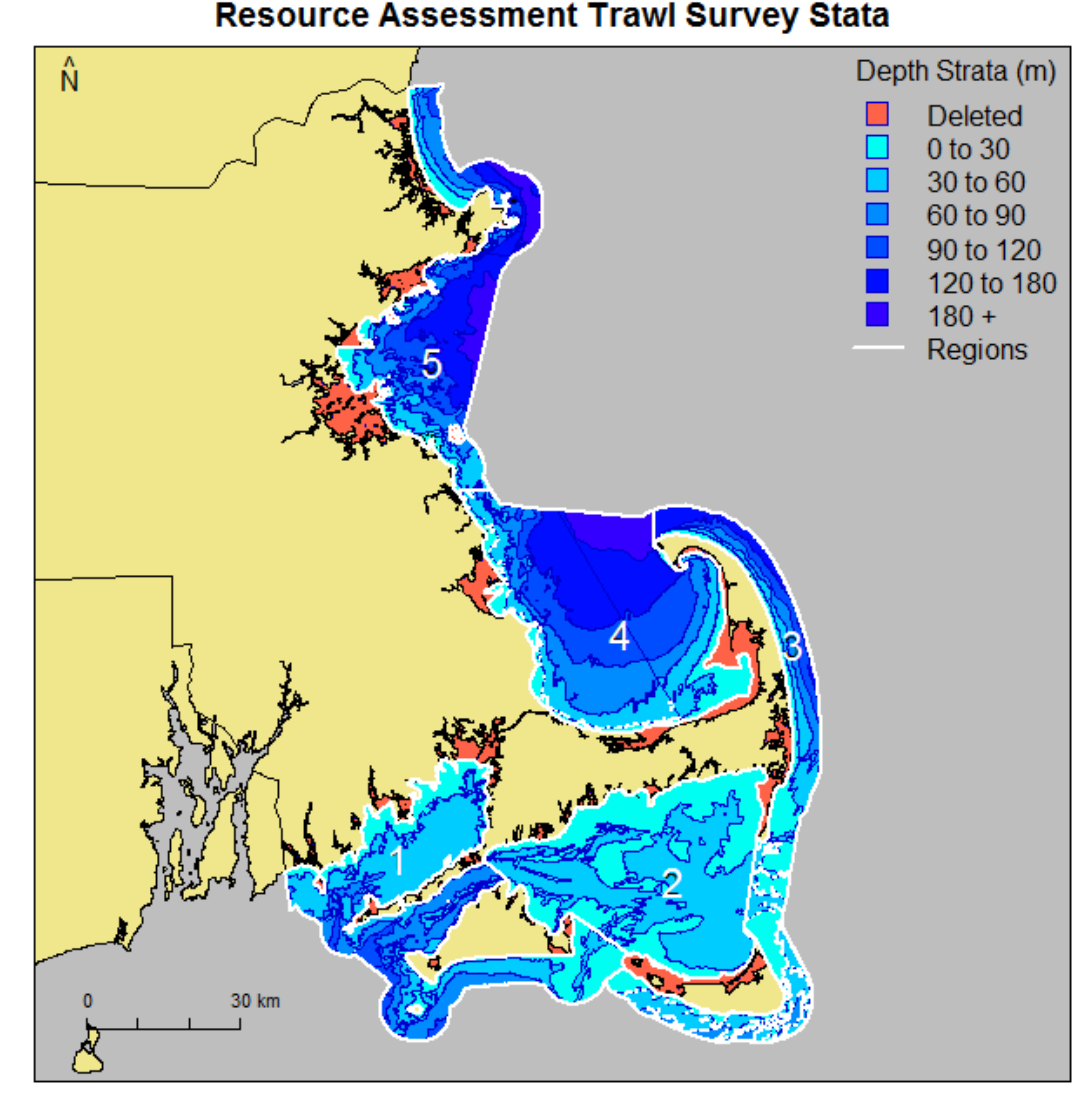
Figure 25. Map of Massachusetts Assessment Trawl Survey